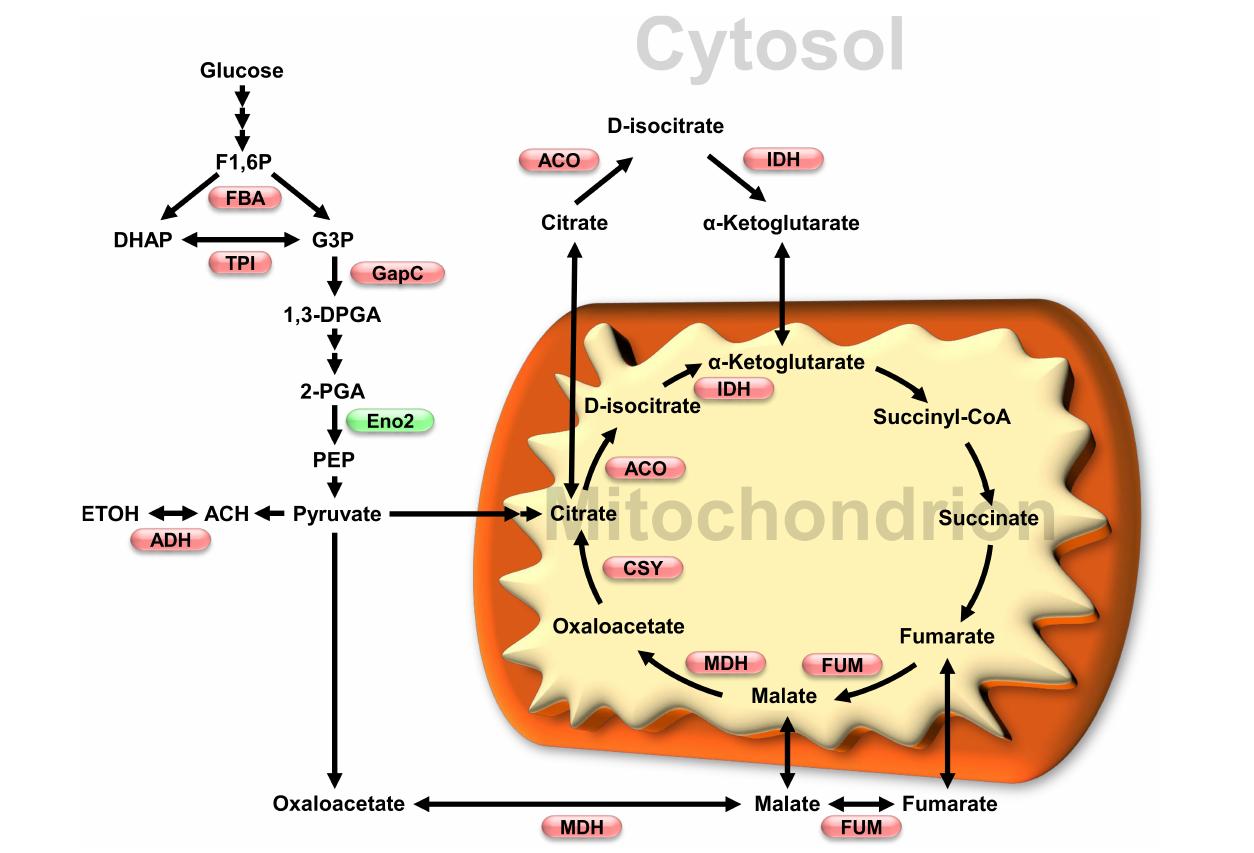
FIGURE 2 | Impact of oxidative stress on glycolytic and TCA cycles enzymes activity. Enzymes which activity has been shown to be affected by redox modification are shown in a metabolic scheme that also includes subcellular localization. Red and green, respectively, indicate inhibition and activation under oxidative conditions. Enzymes and metabolites abbreviations: FBA, fructose-1,6-bisphosphate aldolase; TPI, triosephosphate isomerase; GapC, glyceraldehyde 3-phosphate dehydrogenase; Eno2, enolase 2; ADH, alcohol dehydrogenase; ACO, aconitase; IDH, isocitrate dehydrogenase; MDH, malate dehydrogenase; FUM, fumarase; CSY, citrate synthase. Metabolites: F1,6P, fructose-1,6-bisphosphate; DHAP, dihydroxyacetone phosphate; G3P, glyceraldehyde 3-phosphate; 1,3DPGA, 1,3-bisphosphoglycerate; 2-PGA, 2-phosphoglycerate; PEP, phospho enol pyruvate; ACH, acetaldehyde; ETOH,